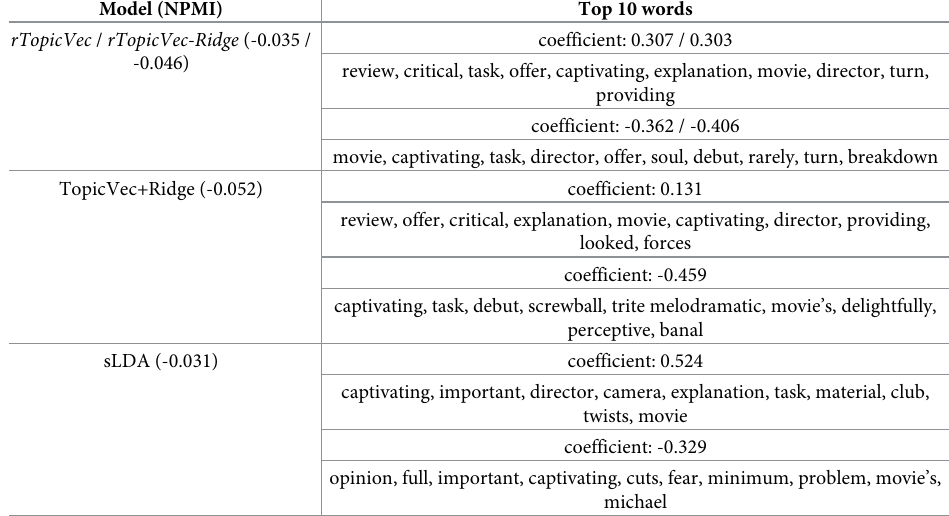
Table 5. Top 10 words of two topics with highest absolute values of regression coefficients and the topic coherence measured in NPMI on the training set when K = 15. Model (NPMI)